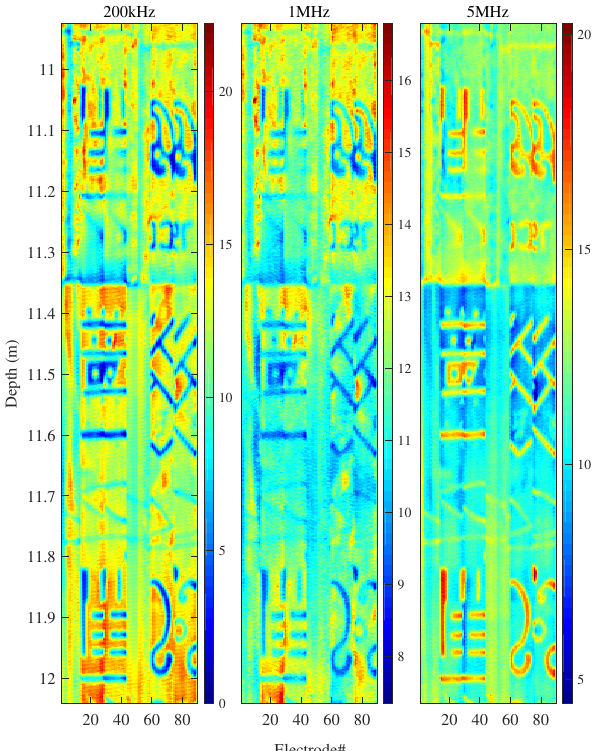
Figure 16. The imaging result of borehole wall patterns with UMMAI sample phases in the third test, while the borehole is filled with water-oil mixed